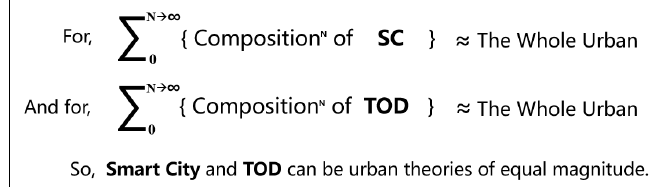
Figure 4. The dialectical relationship between SC and TOD.